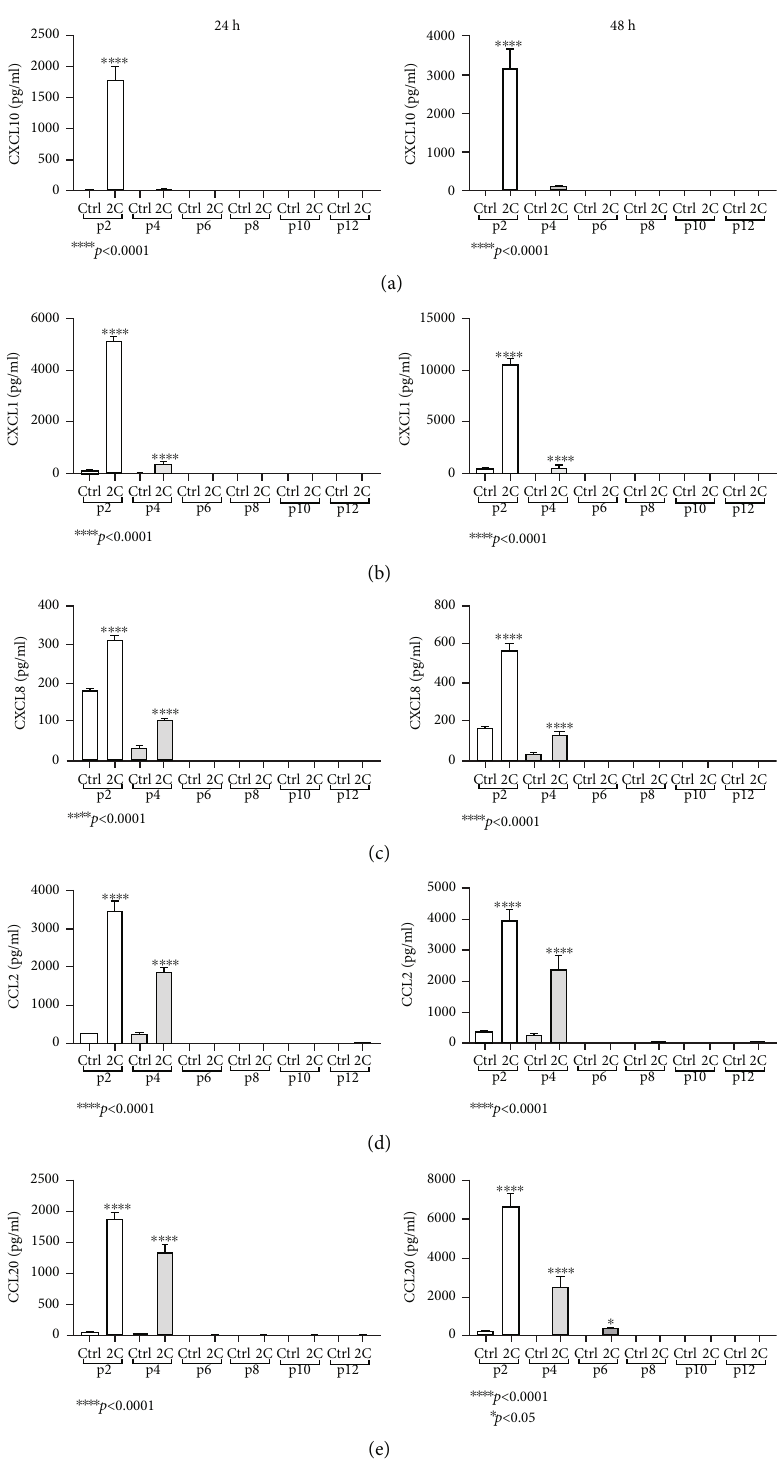
Figure 6: HIOs exhibit mesenchymal and epithelial chemokine protein responses to in fl ammatory cytokines. IL-1 α and TNF- α (2C) 24h and 48h stimulation induced the protein expression of CXCL1 (b), CXCL8 (c), CCL2 (d), and CCL20 (e) in passages 2 and 4, while CXCL10 was induced only in passage 2 (a). CCL20 was also induced in passage 6, after 48h stimulation. Concentrations of cytokines used: IL-1 α 5ng/ml, TNF- α 50ng/ml. All experiments were performed in triplicate. Data are presented as the mean ± standard errorof themean ð SEM Þ